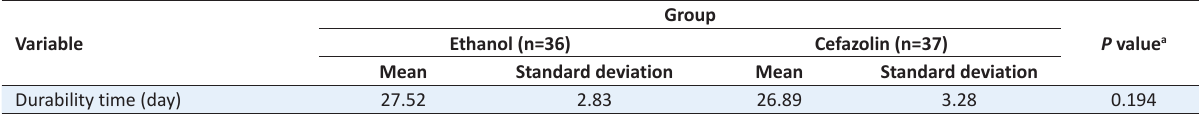
Table 2. Comparison of catheter durability time between two groups of ethanol and cefazolin